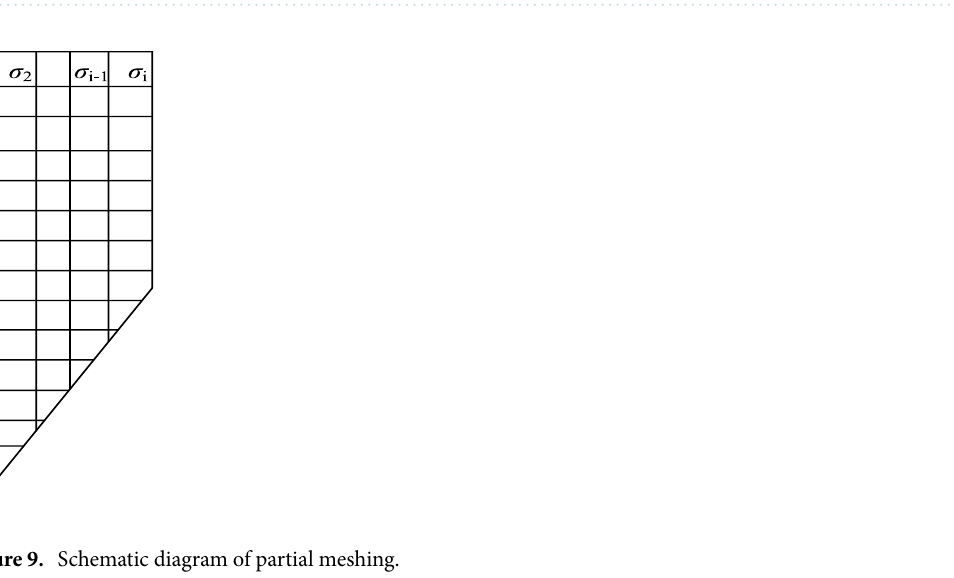
Figure 8. Contour map of displacement contours.